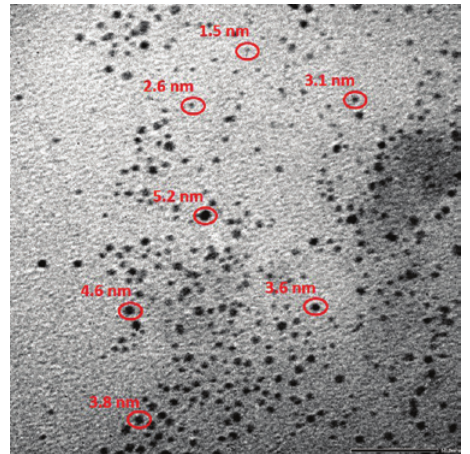
Figure 4: TEM image for synthesized Cu